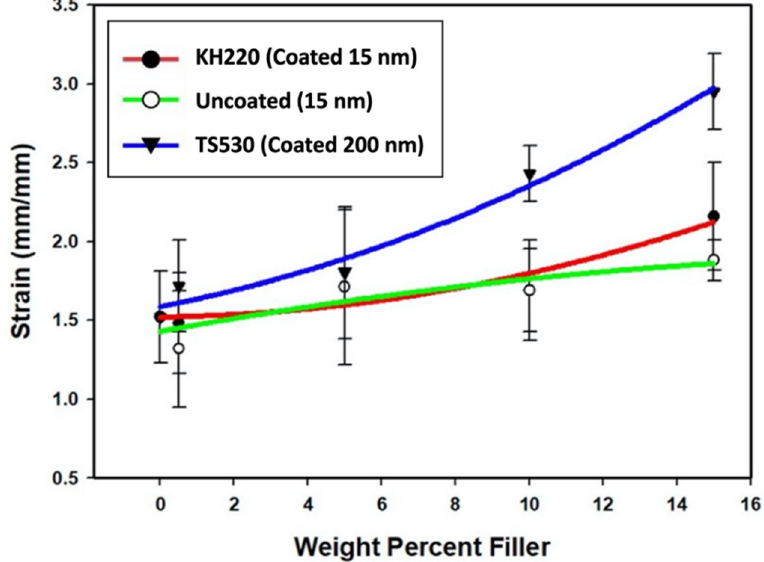
Figure 10. Plots of Failure Strain (mm/mm) Versus Weight Percent Filler For Three Filler Types. Error Bars Represent Standard Errors of Means.